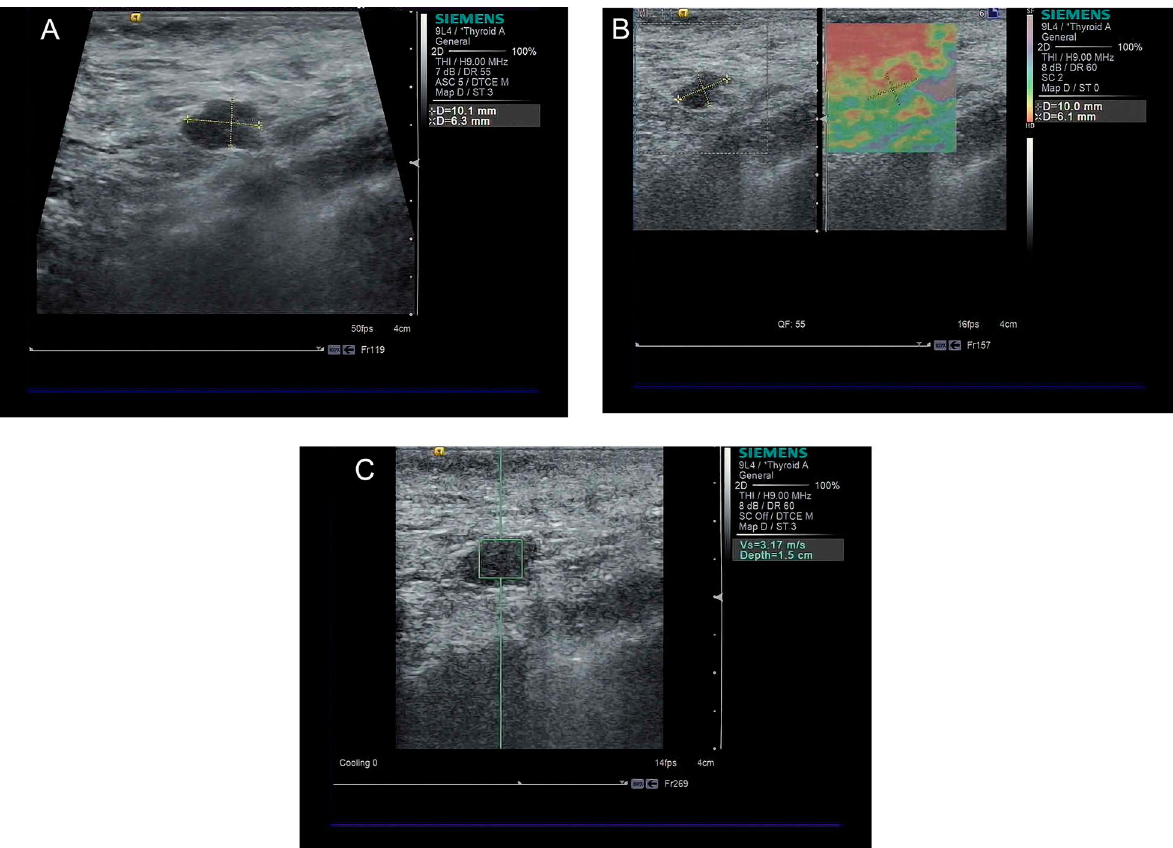
Fig. 5 Metastatic LN erroneously diagnosed as benign by SE and correctly diagnosed as malignant by ARFI. A Grayscale US image of small axillary LN showing hypoechoic texture, lost fatty hilum with long/short axis < 2. B SE image total red area 10–50% consistent with elasticity scale 2. C ARFI showed SWV of 3.17